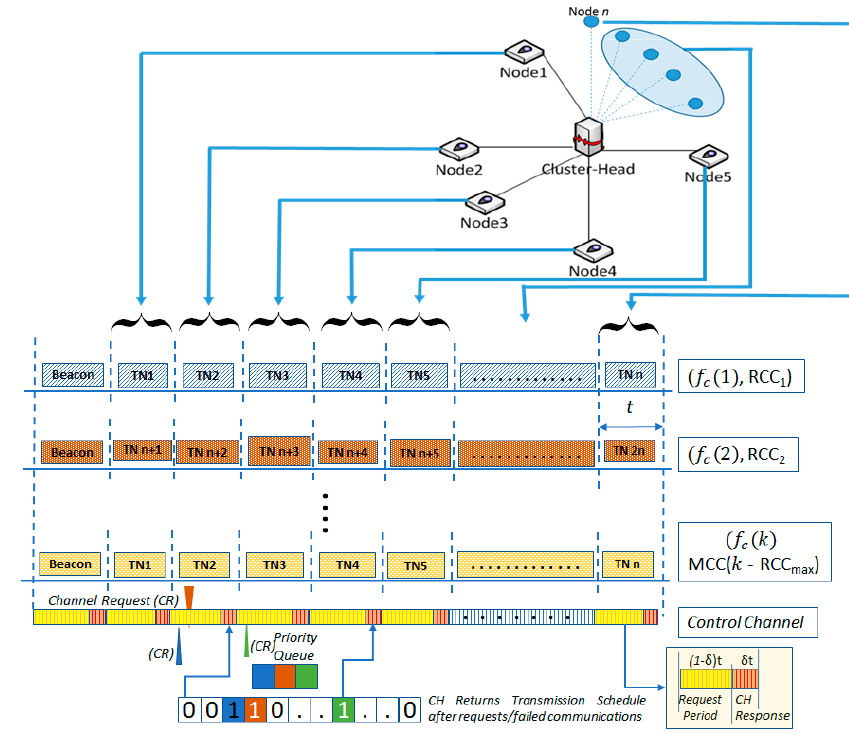
Figure 1. Superframe structure and network topology.